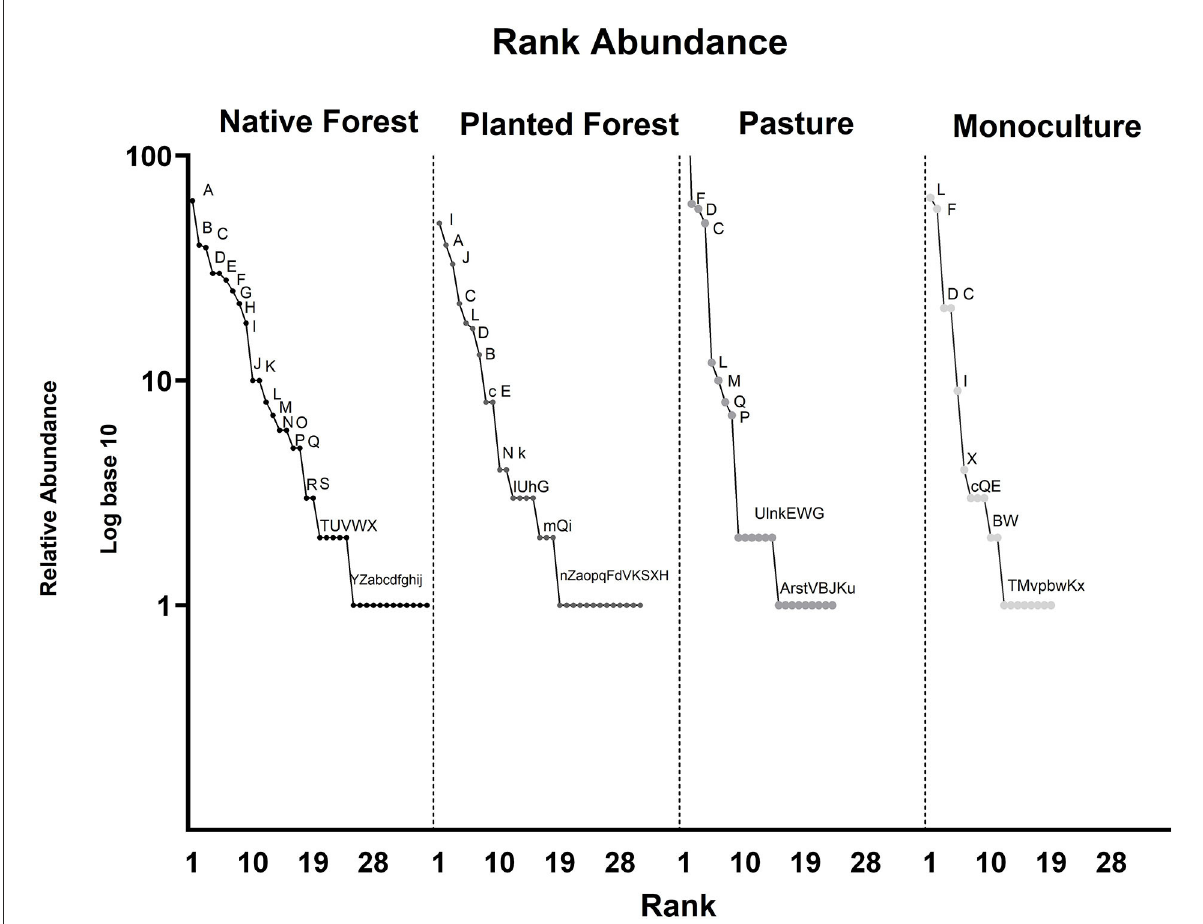
FIGURE2 Rank-abundance curve in logarithm10 of edaphic macrofauna at genus level across land use categories. (A) Holojapyx sp., (B) Forficula sp., (C) Naupactus sp., (D) Heterogomphus sp., (E) Lithobius sp., (F) Eisenia sp., (G) Scolopendra sp., (H) Trombicula sp., (I) Armadillidium sp ., (J) Fufius sp., (K) Julus sp., (L) Lumbricus sp., (M) Aspidolea sp., (N) Cheiracanthium sp ., (O) Meloidogyne sp ., (P) Arachnocampa sp., (Q) Eleodes sp., (R) Naesiotus sp., (S) Phalangium sp., (T) Aphididae sp ., (U) Cyrtotrachelus sp., (V) Euconulus sp., (W) Passalus sp., (X) Stomoxys sp., (Y) Tegenaria sp., (Z) Allonemobius sp., latt asp sp., (b) Ctenus sp., (c) Dermestes sp., (d) Ensifera sp., (e) Gasterophilus sp., (f) Gonipterus sp., (g) Leiobunum sp., (h) Loxosceles sp., (i) Sitophilus sp., (j) Synoeca sp., (k) Enicmus sp., (l) Agriotes sp., (m) Calliphora sp., (n) Agrotis sp., (o) Chactas sp., (p) Cimex sp., (q) Drosophila sp., (r) Aphrastus sp., (s) Centrotus sp., (t) Cydia sp., (u ) Melyris sp., (v) Cecidomyia sp., (w) Hydropsyche sp., and (x) Trypoxylon